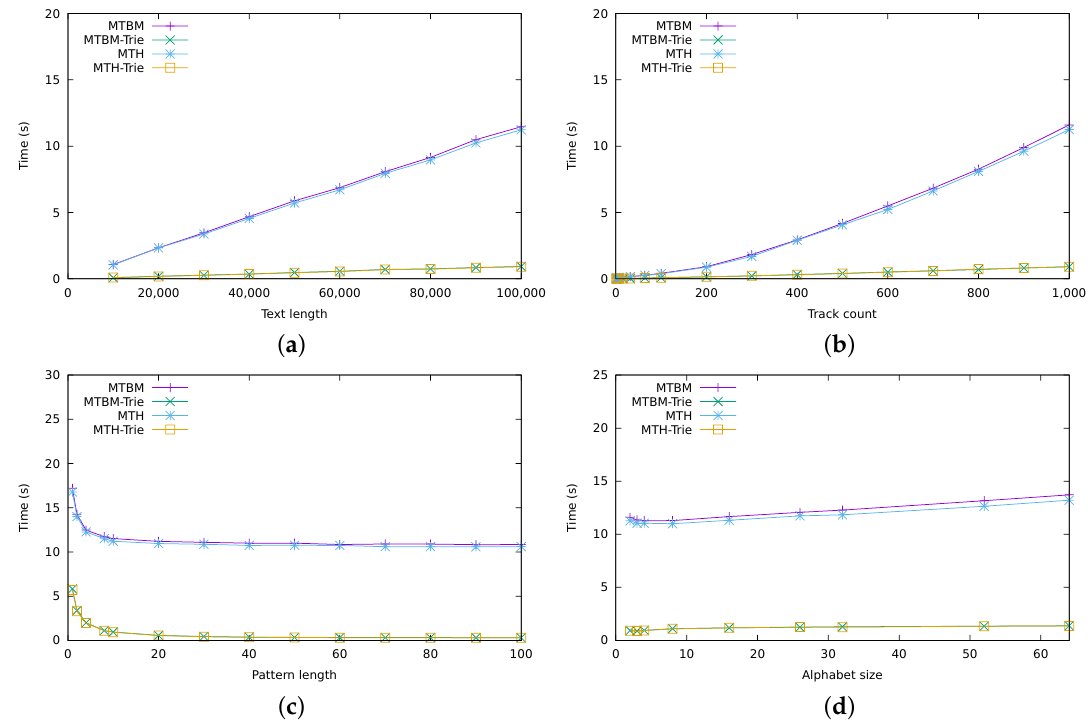
Figure 5. Running time of the multi-track Buyer–Moore (MTBM) and multi-track Horspool (MTH) algorithms on permuted pattern matching with respect to ( a ) the text length, ( b ) the track count, ( c ) the pattern length, and ( d ) the alphabet size.